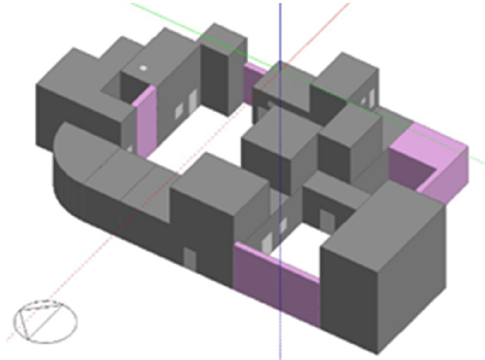
Figure 18. Hail Tradition house without courtyard corridor (Case 2).